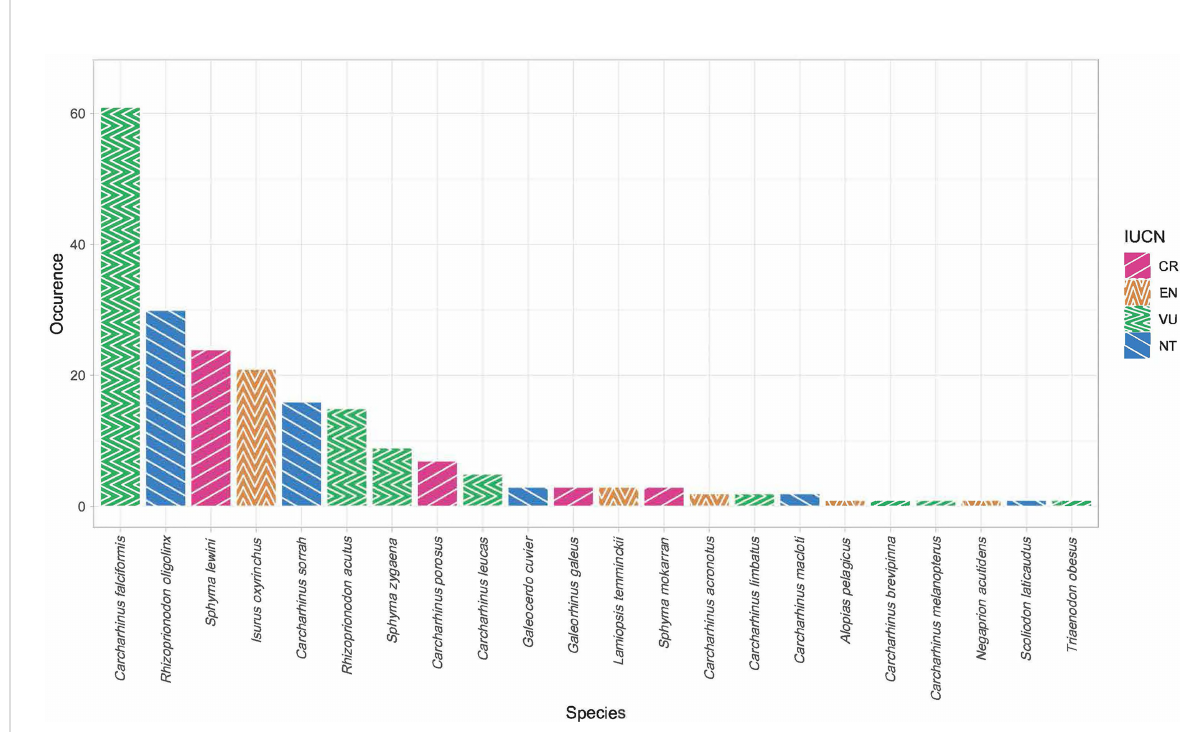
FIGURE 2 Bar chart showing species occurrence and their respective IUCN Red List status (CR, critically endangered, EN, endangered, VU, vulnerable, NT, near threatened). Only samples identi fi ed to the species level are